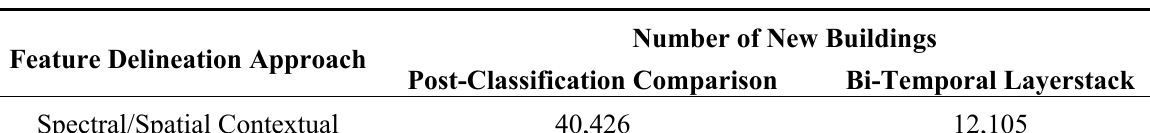
Table 3. Number of Delineated New